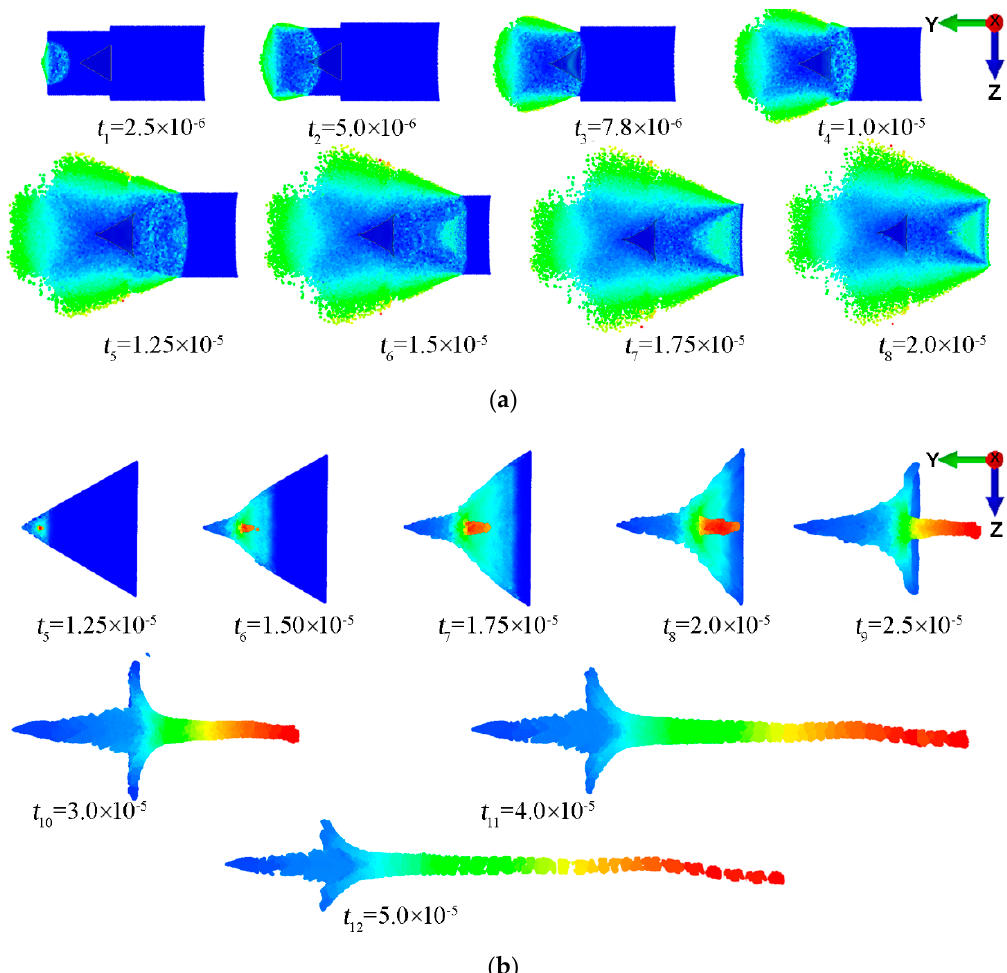
Figure 12. Stages of jet formation of the peripheral charge for individual time steps: ( a ) the process of propagation of an explosion detonation wave onto an additional insert in order to increase the angles of incidence on the liner; ( b ) stages of the jet formation in main liner.